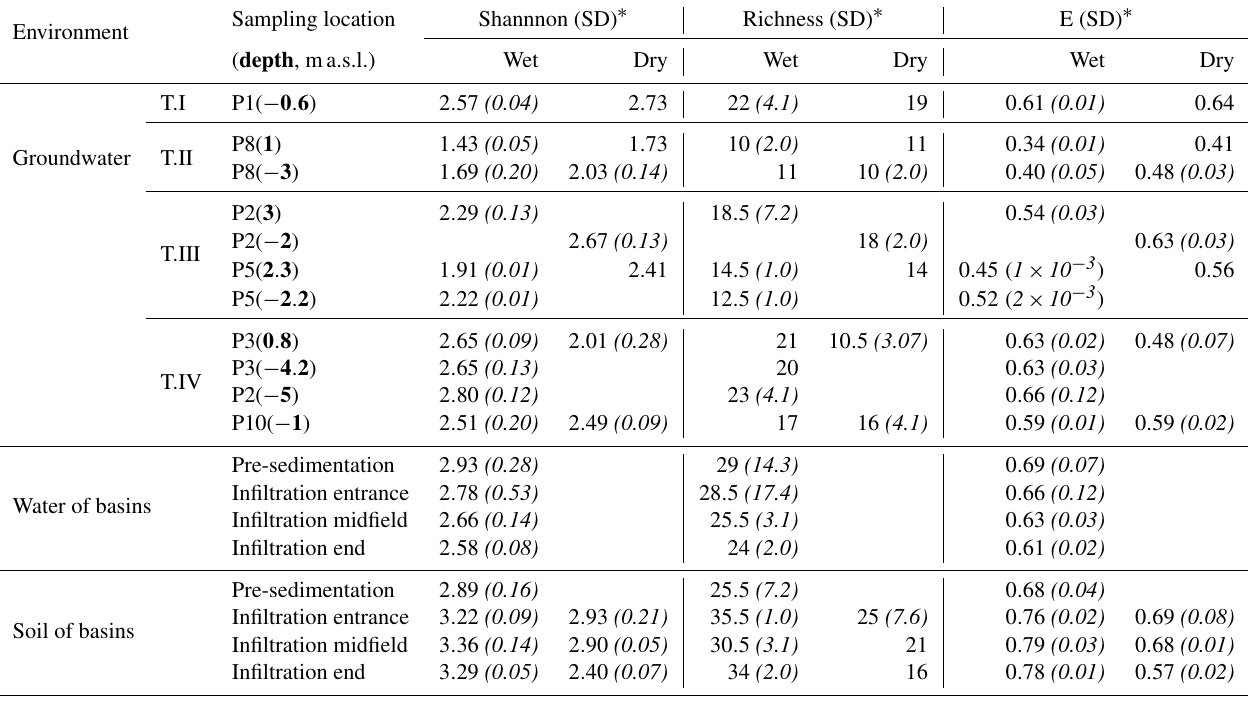
Table 1. Summary of values of the Shannon, richness and evenness indices at the Llobregat MAR site in different scenarios.